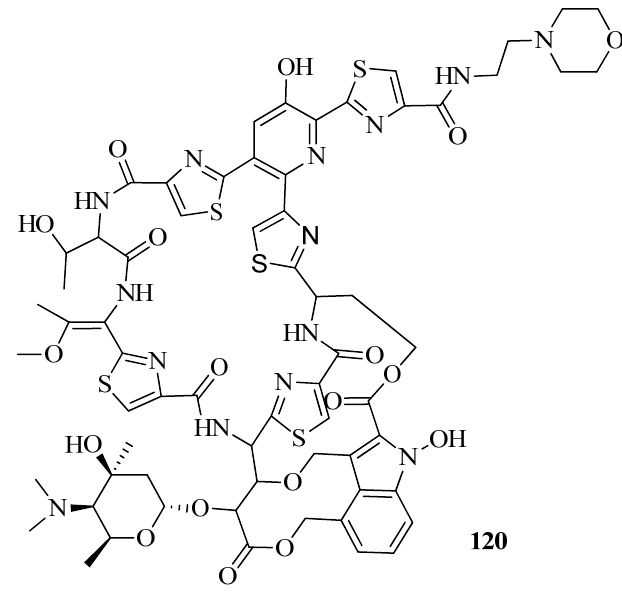
Figure 50. Structure of Nocathiacin I